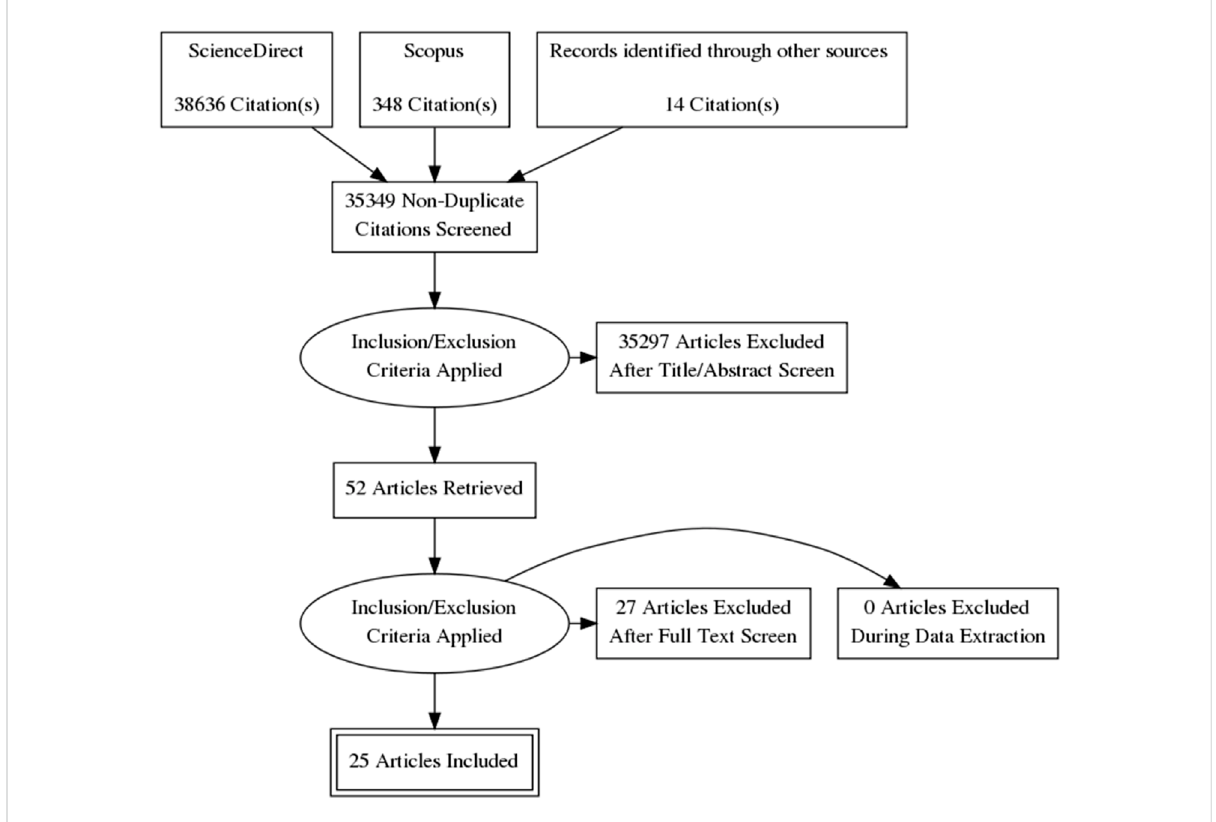
FIGURE 1 Flow diagram of included and excluded studies in the review.